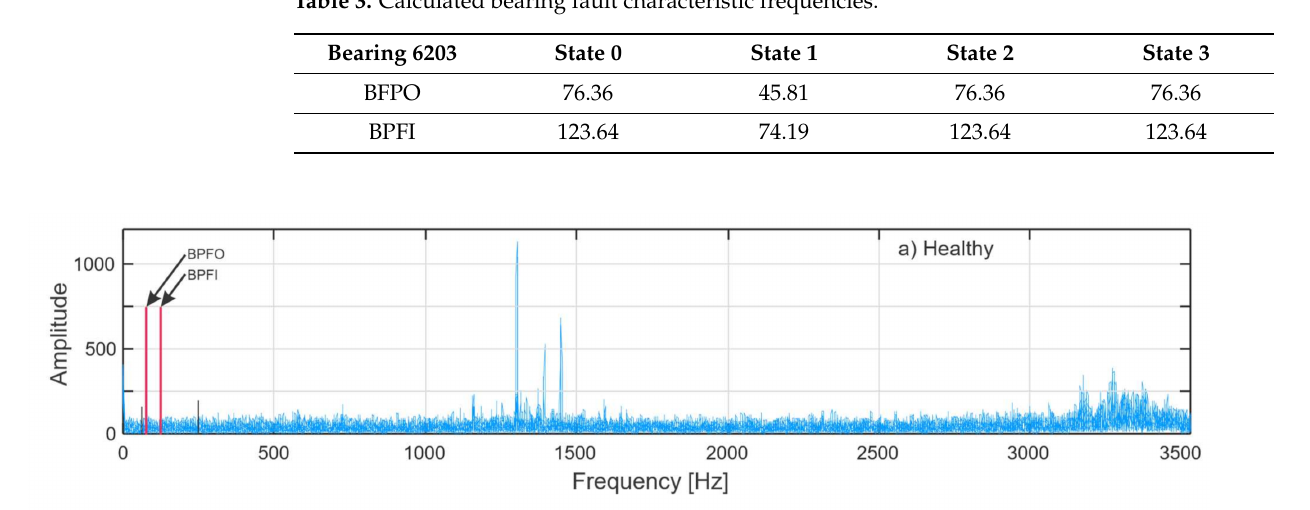
Table 3. Calculated bearing fault characteristic frequencies.